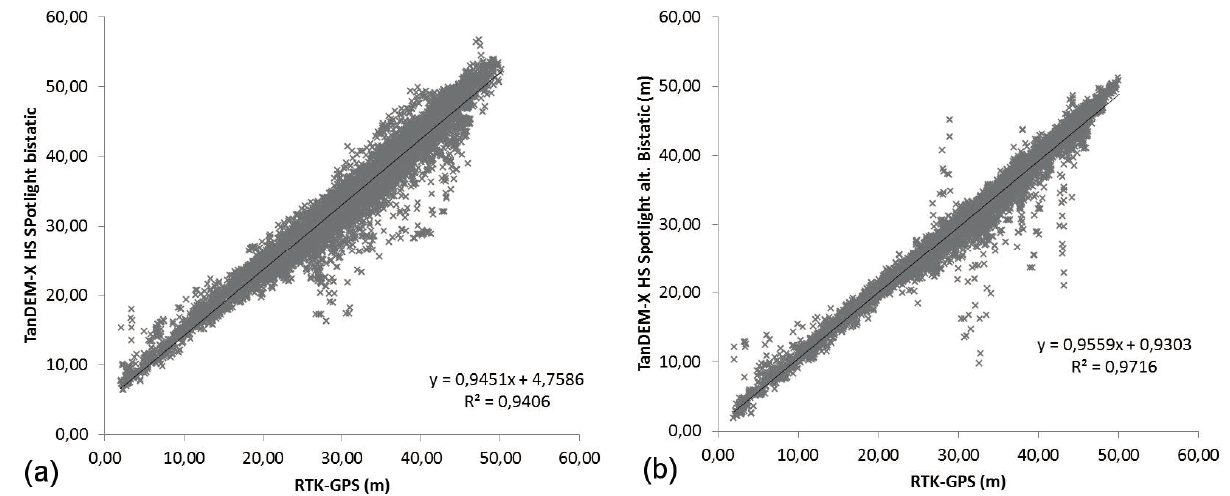
Figure 8. Linear correlation between RTK-GPS field survey and TanDEM-X HS absolute height values. ( a ) TanDEM-X bistatic processing (ALT-1); ( b ) TanDEM-X alternating bistatic merge processing